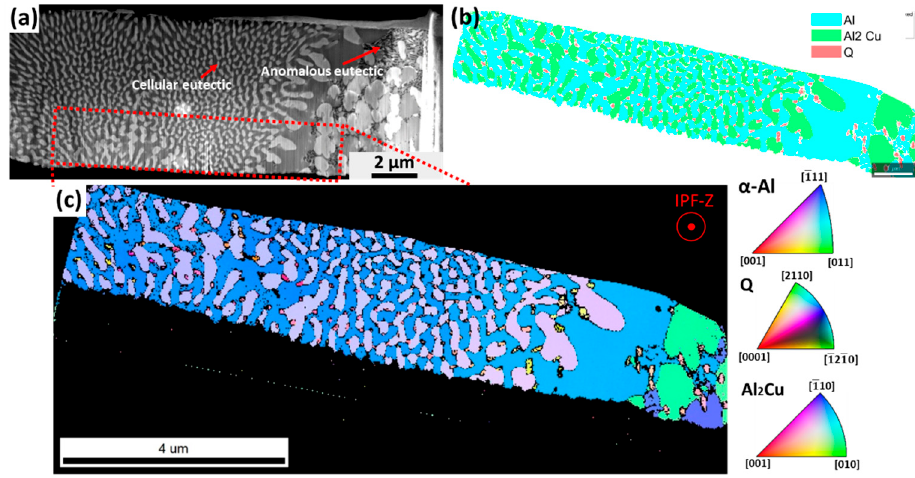
Figure 7. ( a ) SEM image showing the FIB-milled lamella ( b ) SEM-TKD map of eutectic phases distribution ( c ) inverse pole figure (IFP) map of the eutectic region taken from the area marked in ( a ), showing the inverse pole figure directions along IPF-Z.